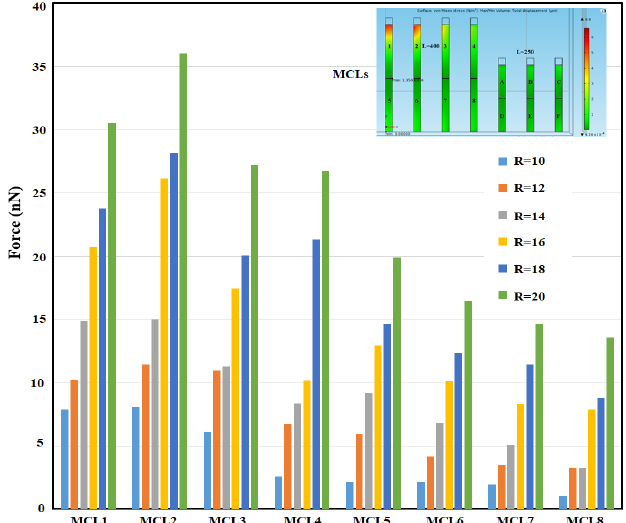
Figure 13. The force generated on MCLs for different microhole radii varied from 10 to 20 µm. The forces are all in nN scale. Here just the forces on MCLs with L = 400 µm are shown. Forces on each component are calculated and is regarded as the input for further simulation for electrical or mechanical assessments. The microhole opened at the center of the chip (see Figure 4), and the results show the force generated from that hole.